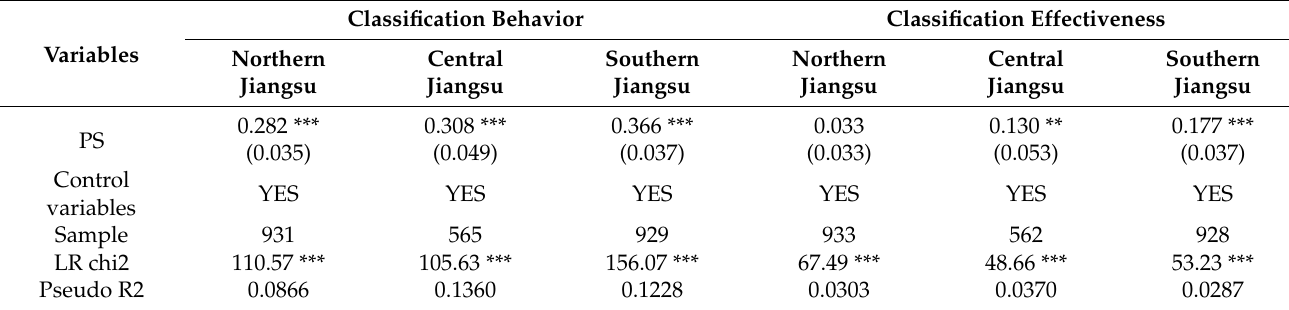
Table 7. Spatial effects of policy support: marginal